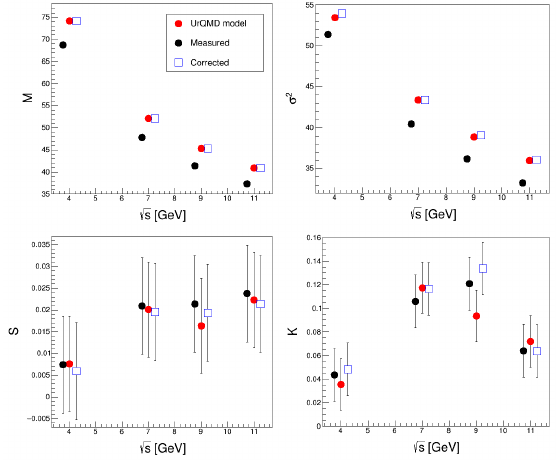
Figure 8: Mean, variance, skewness and kurtosis as a function of